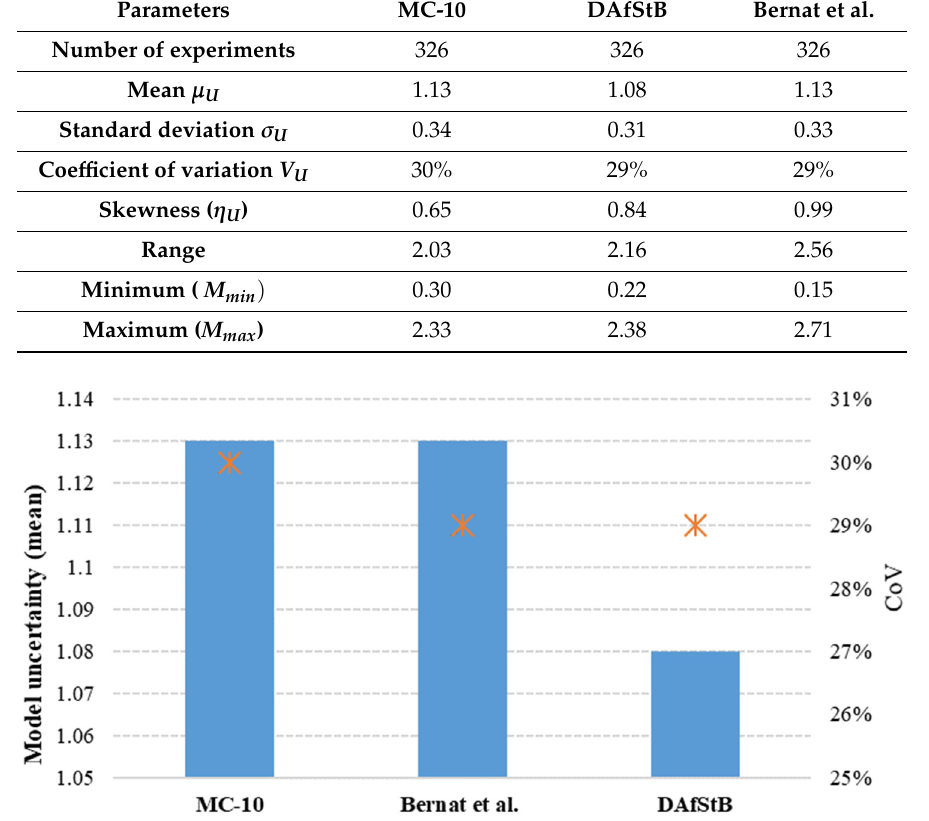
Table 3. Statistical properties of the model uncertainty variables.